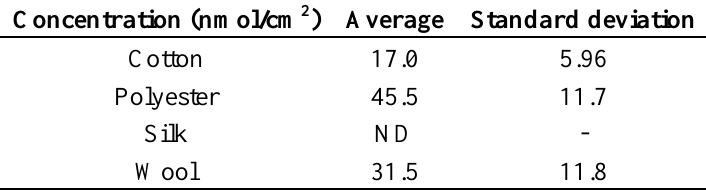
Table 2. Residual concentrations of PCE on